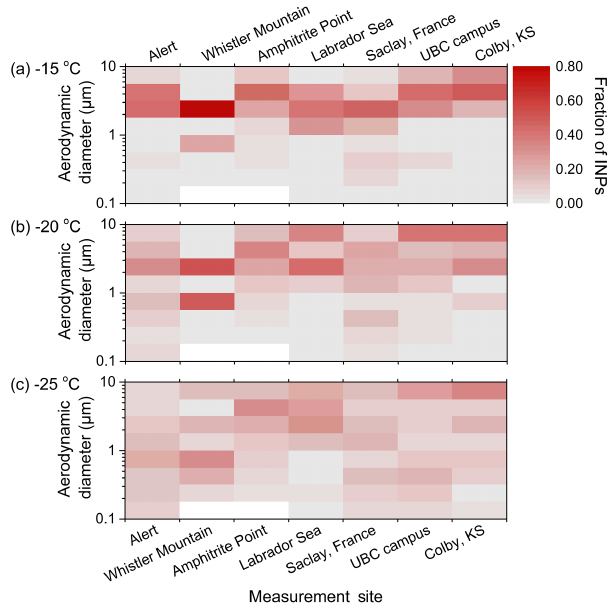
Figure 5. Fractional INP concentrations as a function of aerosol particle size, location, and activation temperature: (a) − 15 ◦ C; (b) − 20 ◦ C; and (c) − 25 ◦ C. The color bar indicates the fraction of INPs measured in each particle size bin. Aerosol particle sizes cor- respond to the 50% cutoff aerodynamic diameters of the MOUDI stages (Marple et al., 1991). Missing sizes for the Whistler Moun- tain and Amphitrite Point sites are